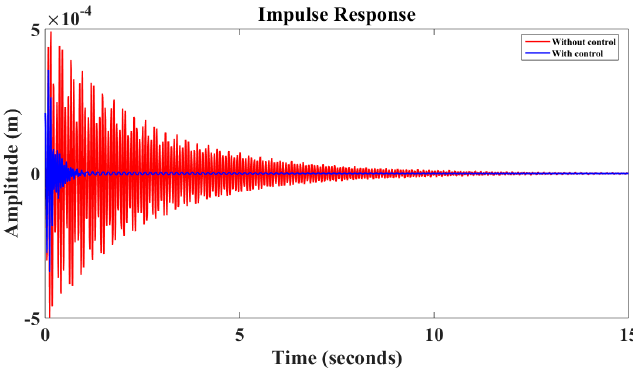
Figure 15. Impulse response of the beam (Sensors in FE4, Q = 10 8 , R = 1, Gc = 100).